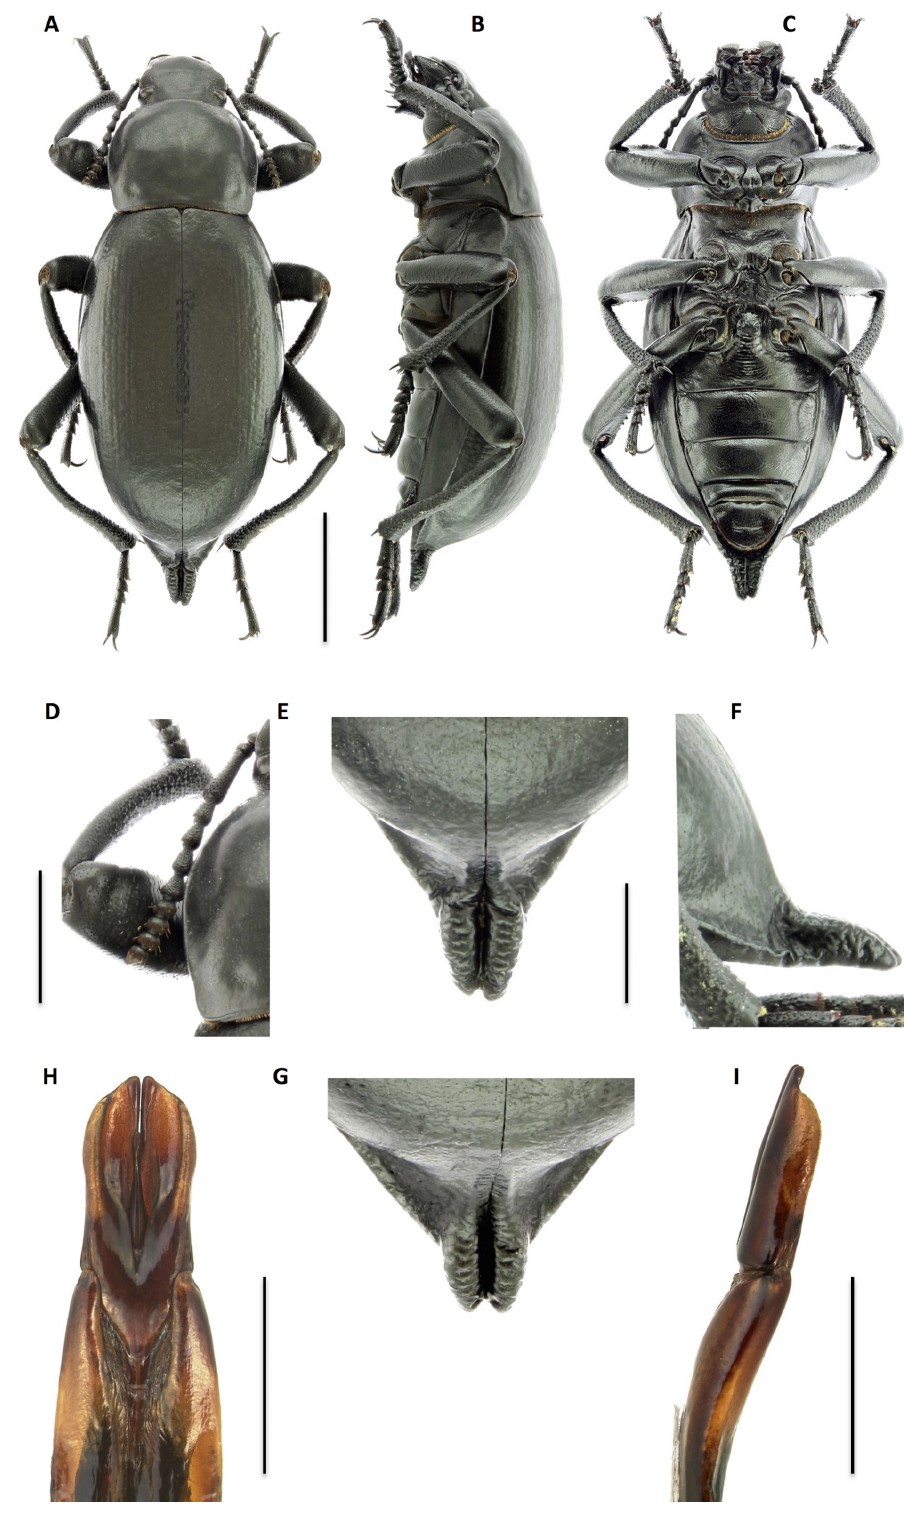
Fig. 4. Blaps nitiduloides Soldati sp. nov. A . ♂, habitus (dorsal view). B . ♂, habitus (lateral view). C . ♂, habitus (ventral view). D . ♂, left antenna (dorsal view). E . ♂, mucro (dorsal view). F . ♂, mucro (lateral view). G . ♀, mucro (dorsal view). H . ♂, aedeagus (ventral view). I . ♂, aedeagus (lateral view). Scale bars: A–C = 10 mm; D = 5 mm; E–I = 2